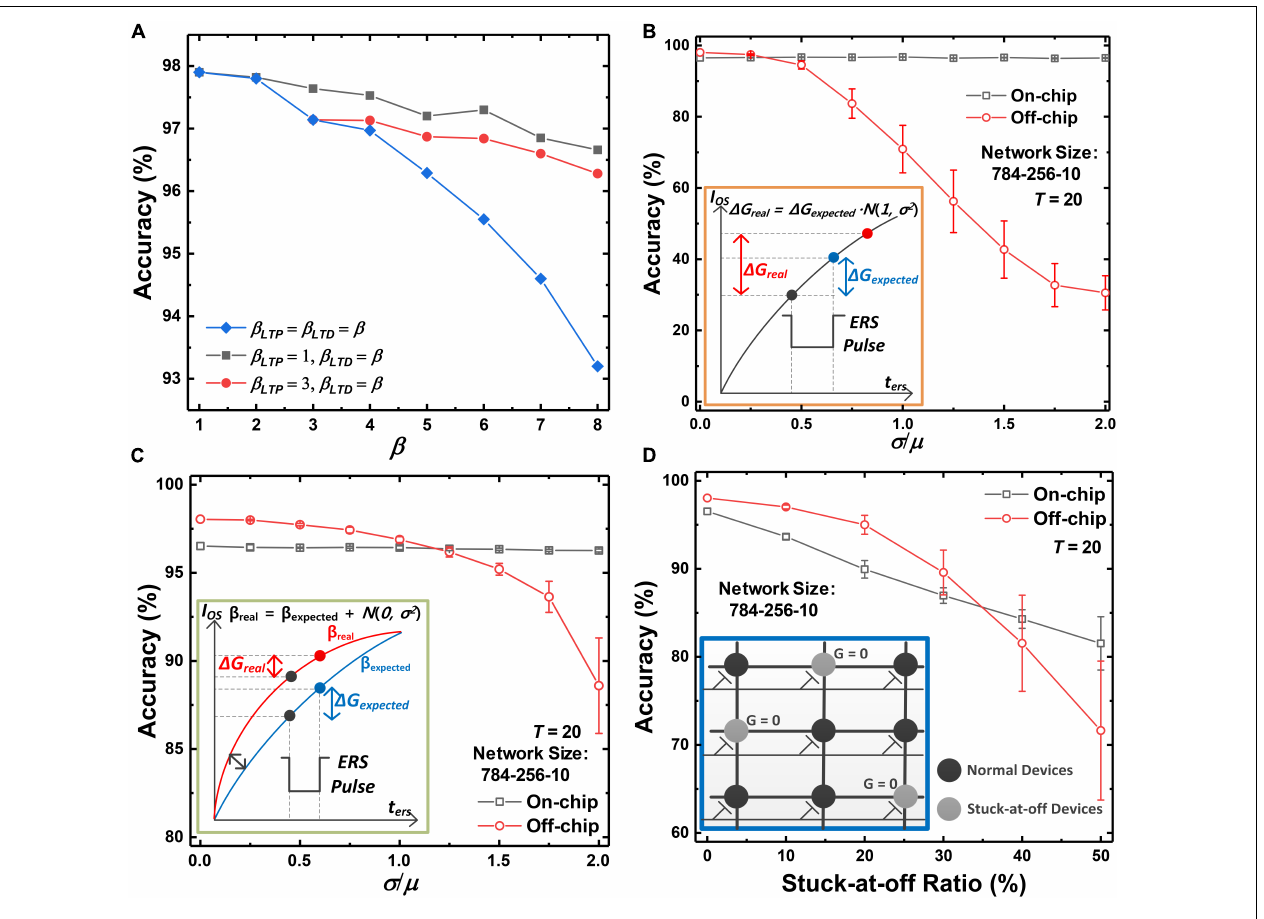
FIGURE 9 | Accuracy of the on-chip training SNN systems versus (A) the non-linearity factor ( β ) of conductance response, (B) pulse-to-pulse variation, (C) device-to-device variation, and (D) stuck-at-off ratio. Although extremely non-linear and asymmetric devices are used as synaptic devices, high accuracy is obtained. Degradation due to pulse-to-pulse variation and device-to-device variation is negligible, but degradation due to the stuck-at-off ratio is